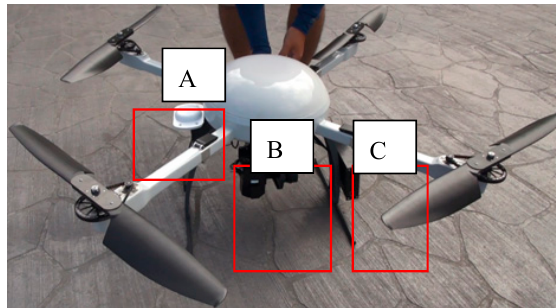
Figure 5. UAV established in this study. ( A ): the antaean; ( B ): XM6 thermal camera; ( C ): BD 970 GNSS OEM board.